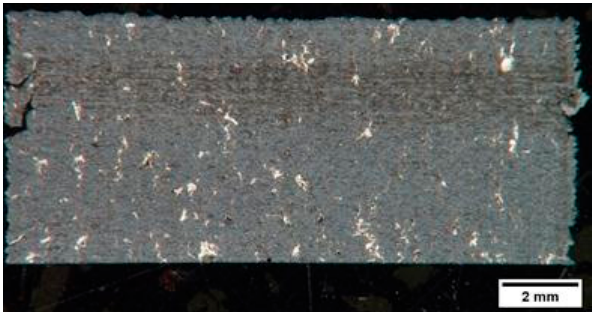
Figure 2. Macrograph of a cross section of a specimen.